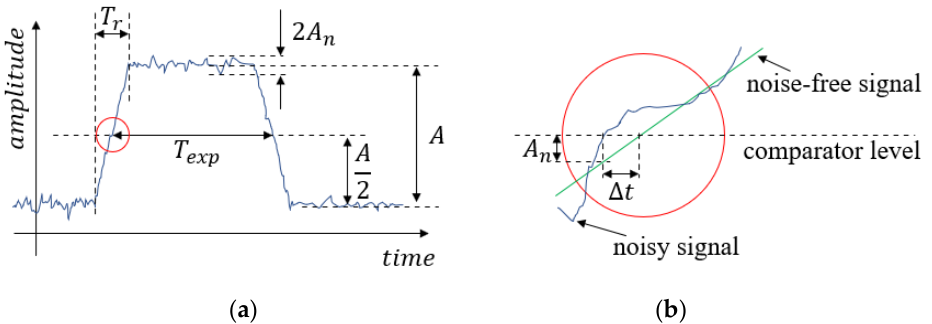
Figure 5. Measurement error of the direct method due to measurement noise. ( a ) Measured quantities, ( b ) measurement error of the rising edge